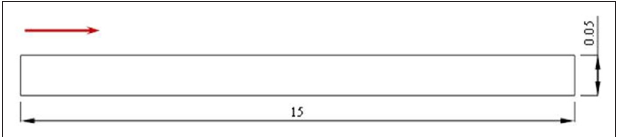
FIGURE 2 | Idealized geometry used to simulate flow of fluid in microchannel.